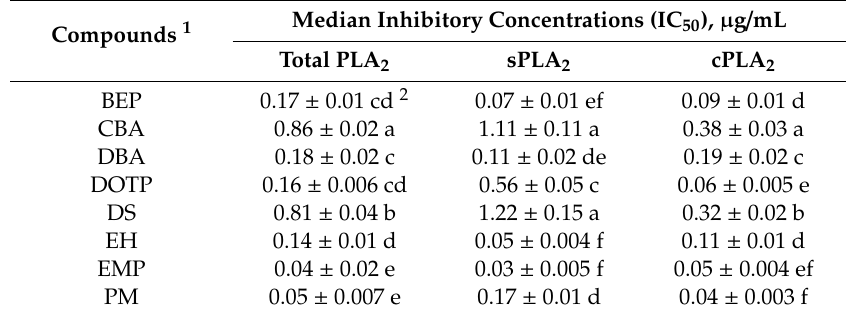
indicate significant di ff erence among means in each column at Type I error = 0.05 (LSD